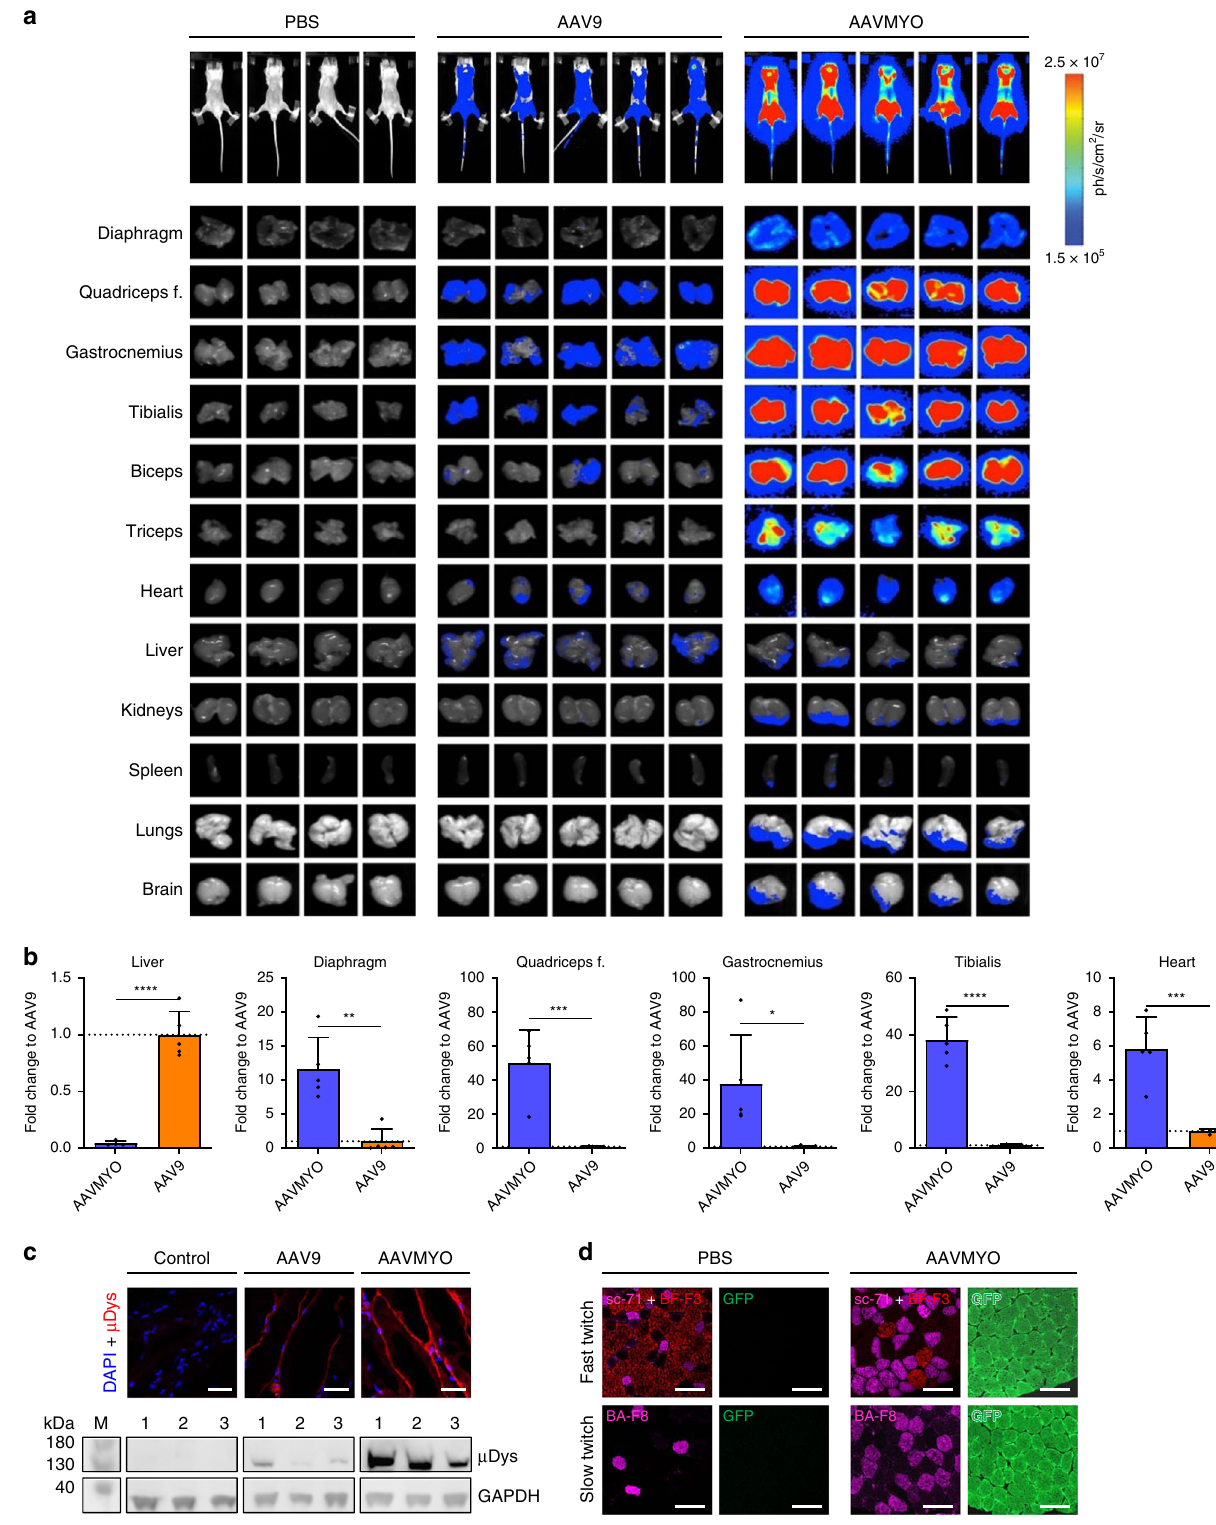
targeted and concurrently liver-detargeted AAV vectors, such as AAVMYO that work from peripheral administration of low doses, considering recent dire events in the ASPIRO gene therapy trial, in which two children affected by XLMTM passed away after delivery of high doses (3 × 10 14 vg per kg) of AAV8, potentially related to off-target liver